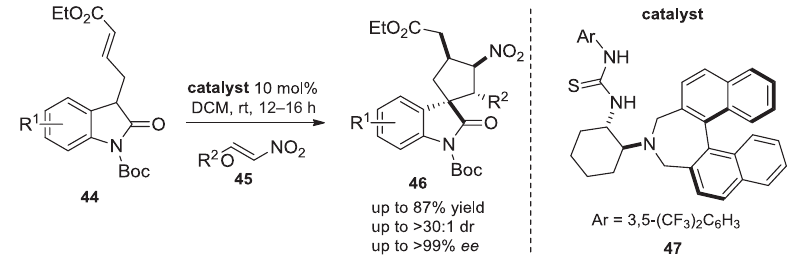
Figure 13. Thiourea catalyzed enantioselective synthesis, from Ref.